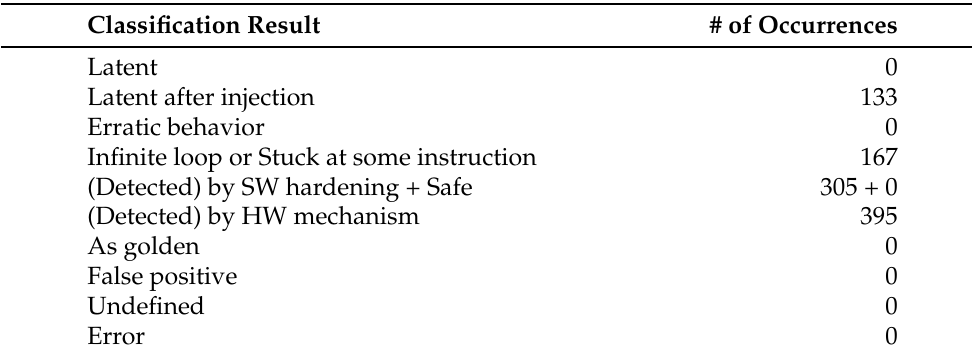
Table 5. Classifier results obtained from the fault injection campaign assessing the RACFED algorithm implemented on the timeline scheduler.